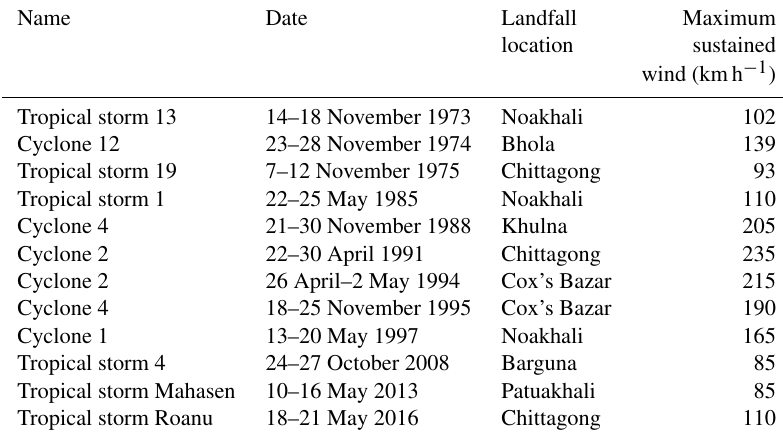
Table 2. List of 12 historical TC events used for ensemble projection of storm surge inundation.